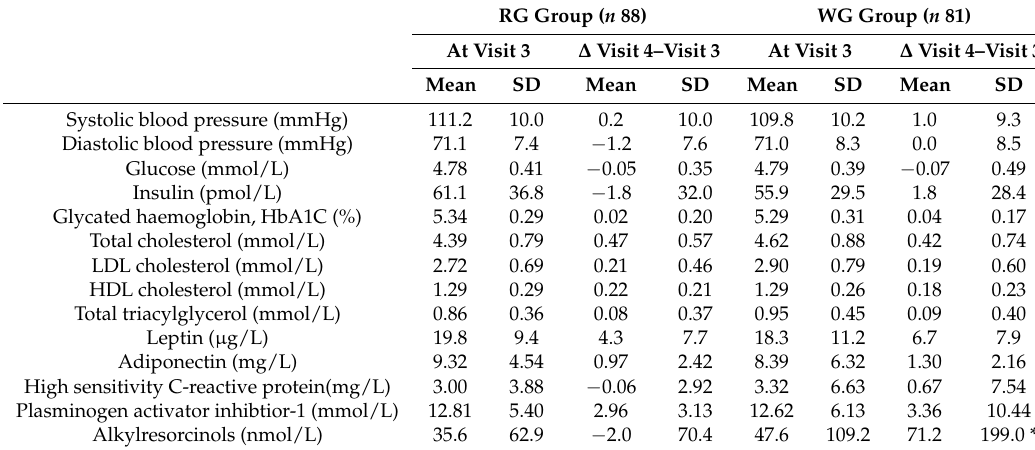
Table 3. Mean values prior to (visit 3) and unadjusted changes in cardiometabolic outcomes and plasma alkylresorcinols during the dietary intervention phase (visit 4–visit 3) in the whole-grain (WG) and refined-grain (RG) groups (mean values with standard deviations